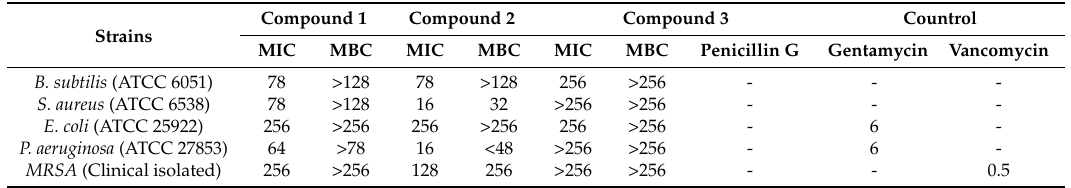
Table 3. Determination of minimal inhibitory concentration and minimal bactericidal concentration of Table 2. 1 H-NMR (400 MHz) and 13 C-NMR (100 MHz) data of compound 3 (in CDCl 3 ). compounds 1 – 3 from scorpion, Buthus martensii karsch ( µ